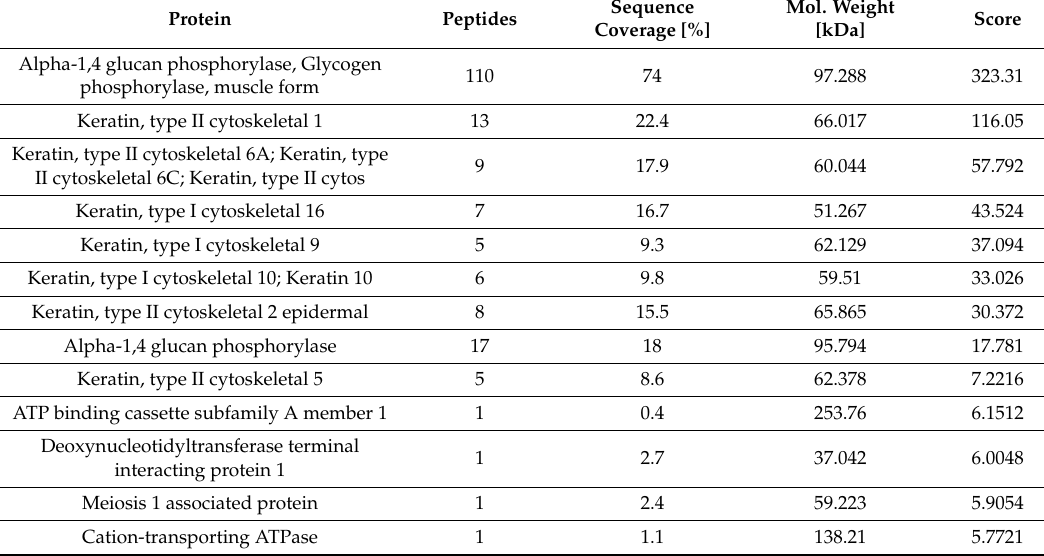
Figure 5. Determination the content of glycogen phosphorylase (GP) by the standard curve method. Table 2. Comparative analysis of protein groups identified by LC-MS/MS.